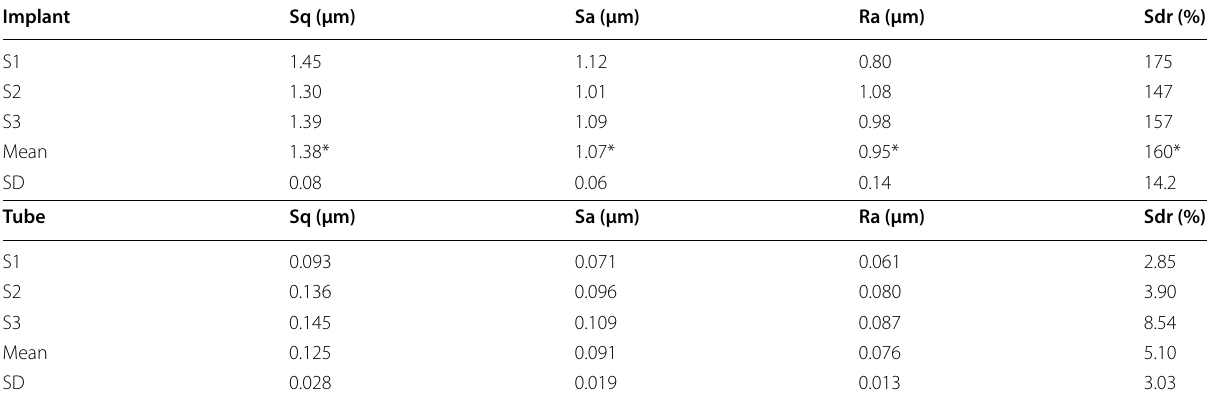
S specimen, SD standard deviation *Significantly higher ( P < 0.05)